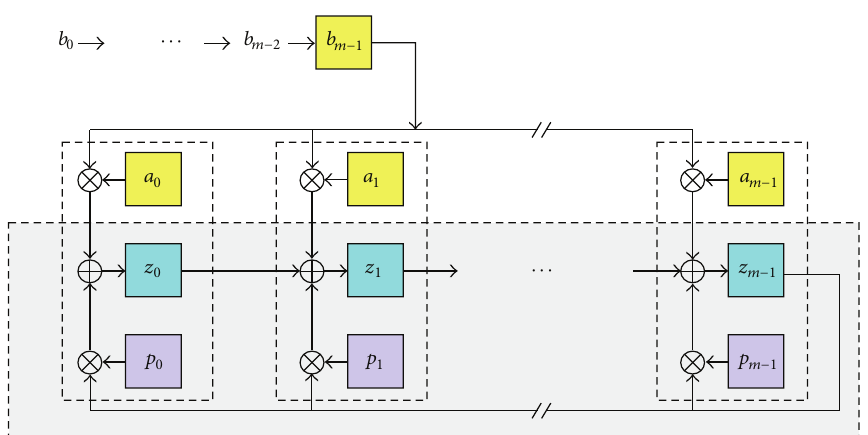
Figure 1: Basic structure of Mastrovito’s serial